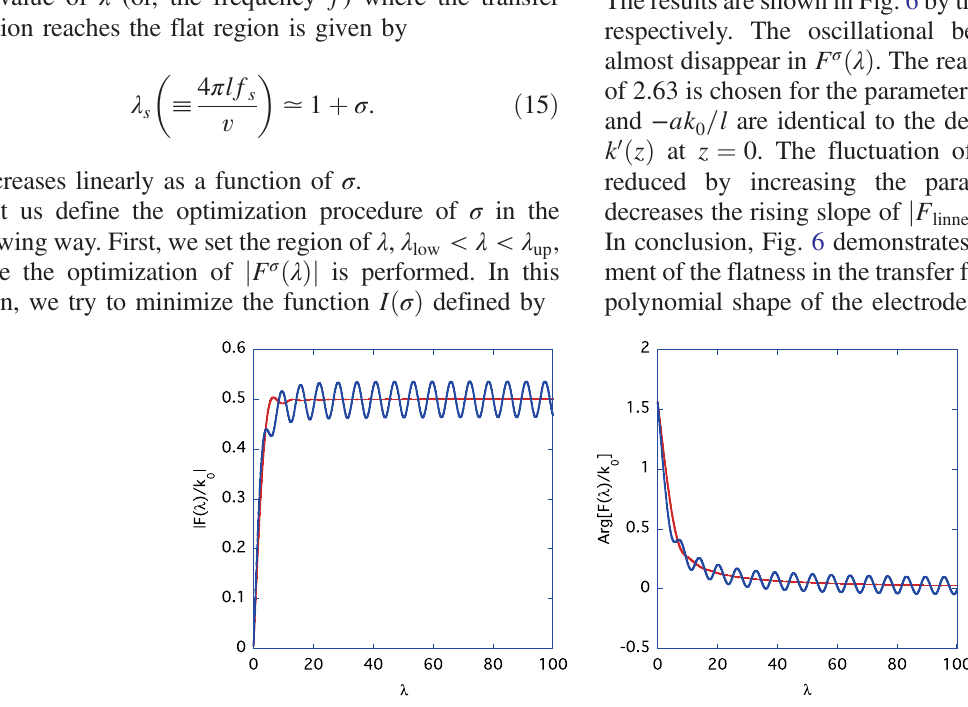
FIG. 6. The phase (right) and amplitude (left) of the transfer function for different shapes of electrodes. The red and the blue lines show the results for the shape given by Eq. (10) with σ ¼ 2 . 63 and those for Eq. (5) with a ¼ 2 . 63 ,